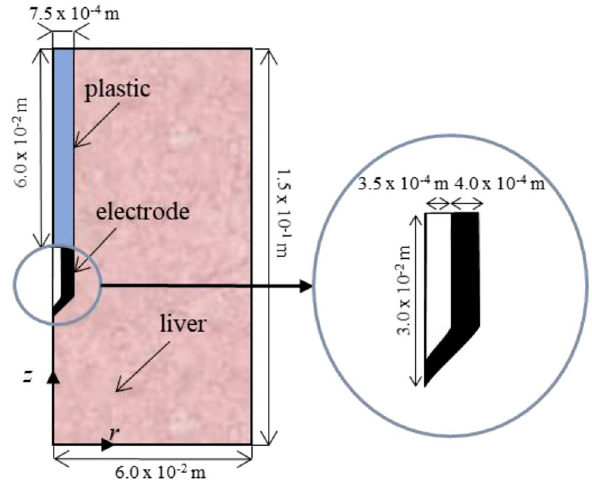
Figure 6. Two-dimensional axisymmetric model consisting of a fragment of liver tissue and an internally cooled electrode (out of scale).